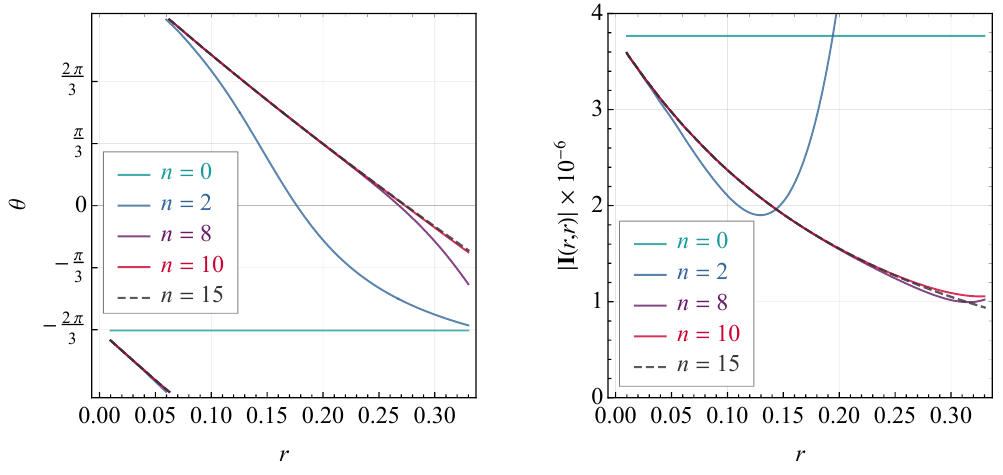
Figure 12 . The convergence of the series in (4.16). We show the result for both the phase and the magnitude of (4.16) by including terms with 0 ≤ n 13 + m 1 , n 24 + m 2 ≤ n , for n = 0 , 2 , 8 , 10 , 15